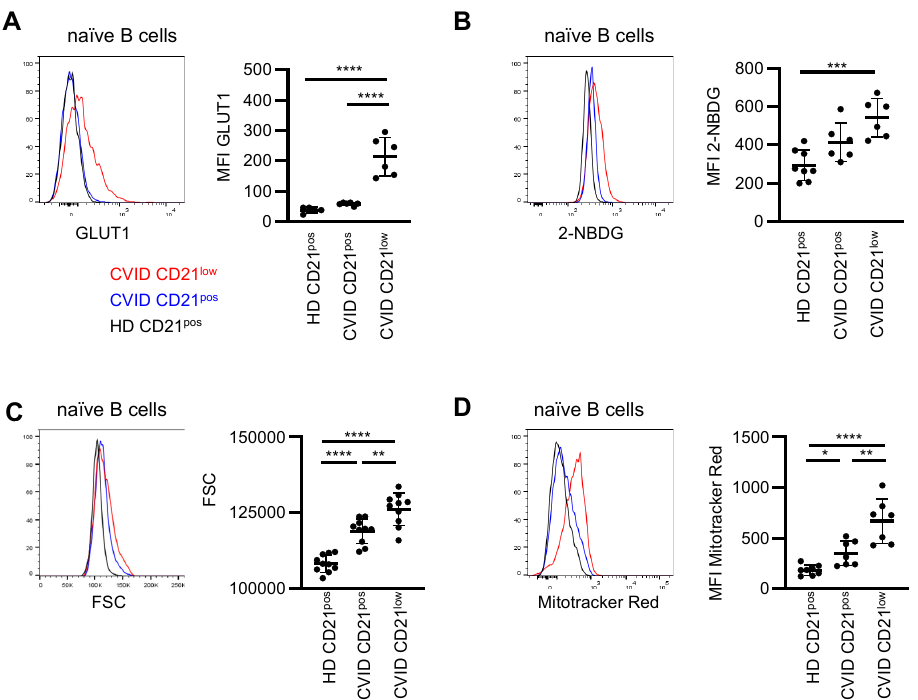
Figure 4. Enhanced metabolic activity in B cells of CVID patients. ( A ) Representative histogram of GLUT1 expression in CD21 pos B cells from HD (black) and in CD21 pos (blue) and CD21 low (red) B cells from CVID patients. Statistical analysis of the relative expression of GLUT1 compared to the respective day control ( n = 11). ( B ) Representative histogram for 2-NBDG and statistics thereof ( n = 6–8). ( C ) Representative histogram overlay and statistics of the FSC ( n = 10). ( D ) Representative histogram overlay displaying MitoTracker Red and statistics of the MFI ( n = 7–8). * p < 0.05, ** p < 0.01, *** p < 0.001, **** p < 0.0001.